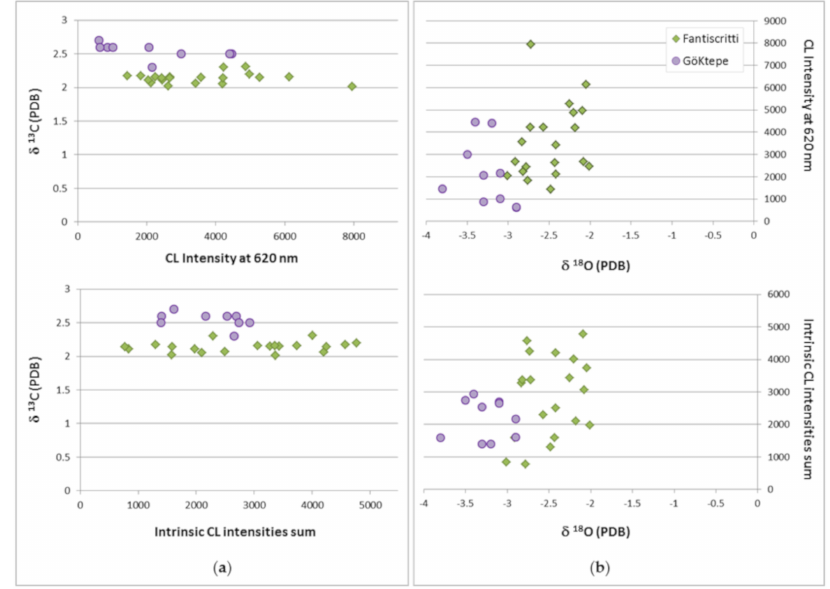
Figure 10. Di ff erent diagrams for Carrara (Fantiscritti) and Göktepe marbles using quantitative CL data obtained in this study and C and O stable isotopes from the literature [20,30]. ( a ) Two diagrams using quantitative CL versus δ 13 C; ( b ) two diagrams using quantitative CL versus δ 18